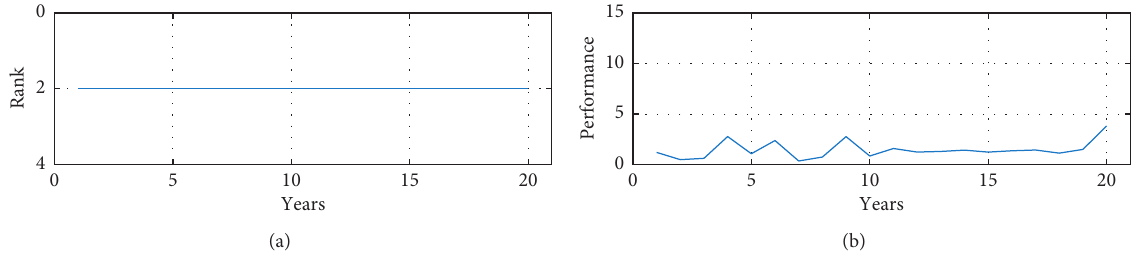
Figure 4: Rank history (a) and performance (b) of agent 9. During the simulation the employee 9 does not change his/her rank.